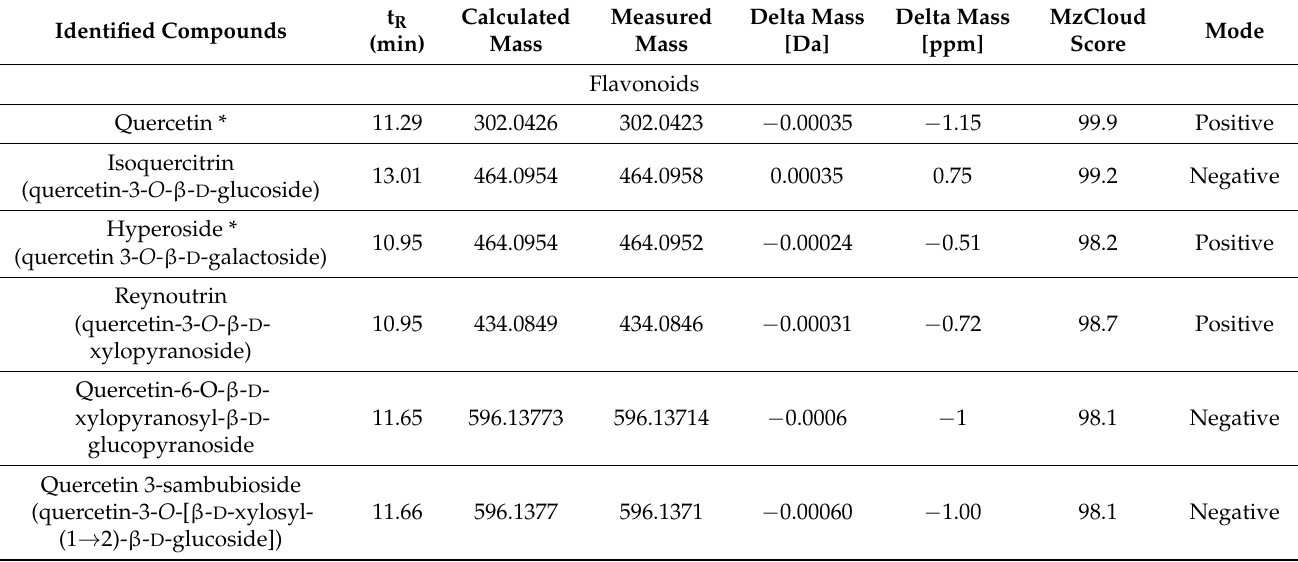
Table 1. Chemical constituents identified in E. longistipitata leaves (aqueous-ethanol extracts) using LC-HRMS, mzCloud, and